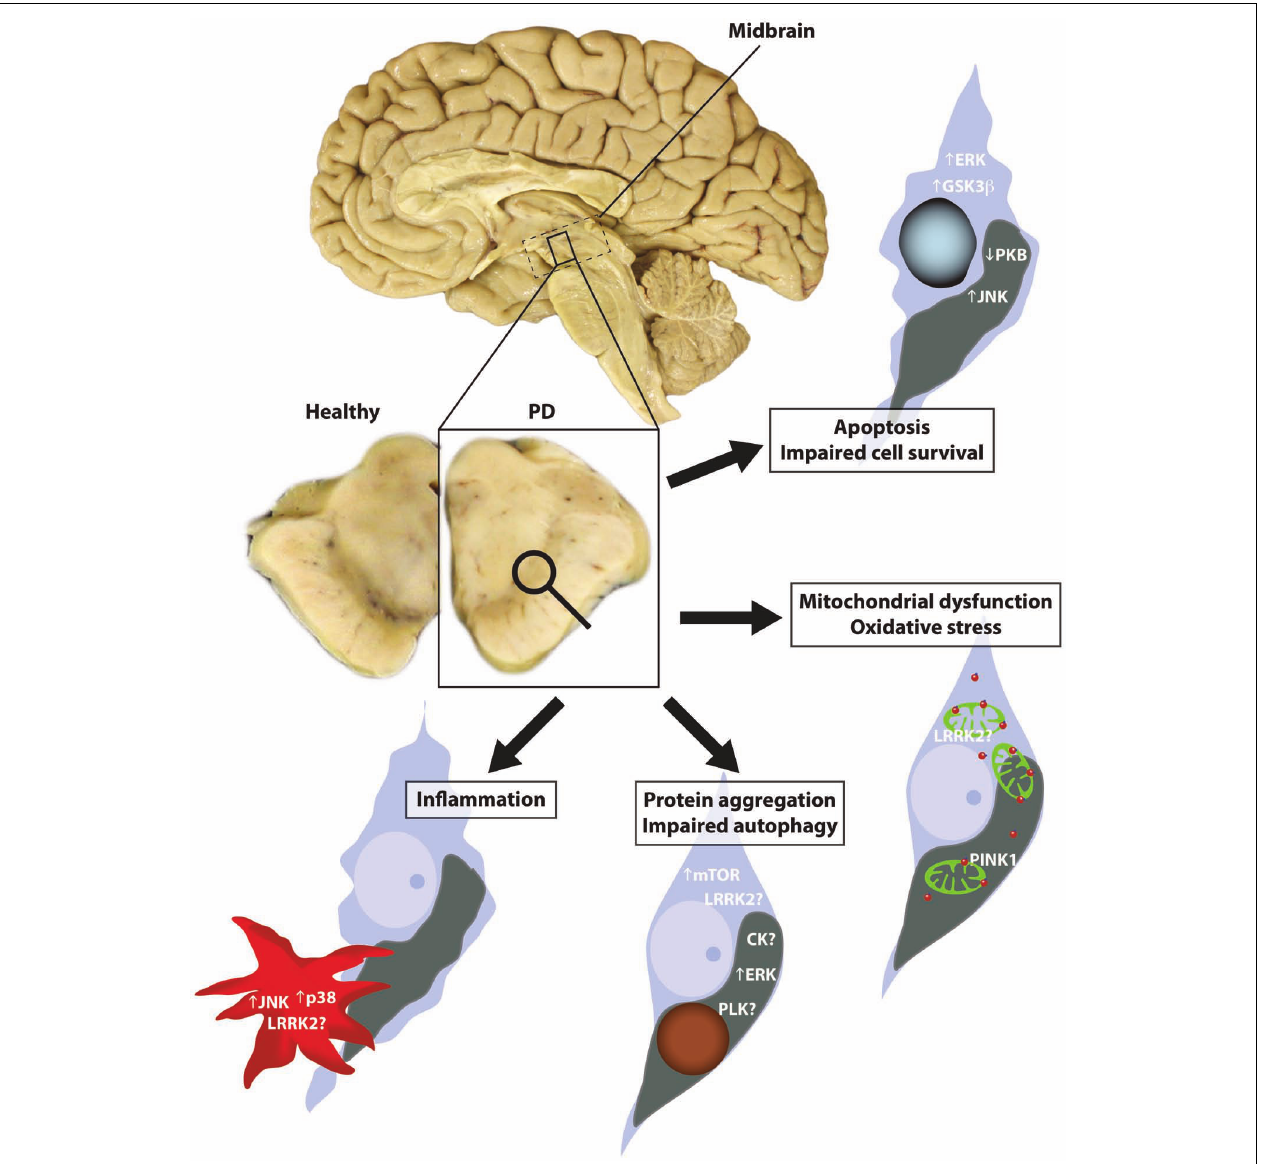
FIGURE 4 | Kinases implicated in Parkinson’s disease (PD). PD is characterized by the loss of pigmented dopaminergic neurons in the substantia nigra region of the midbrain. A number of biological processes have been implicated in this neuronal loss including mitochondrial